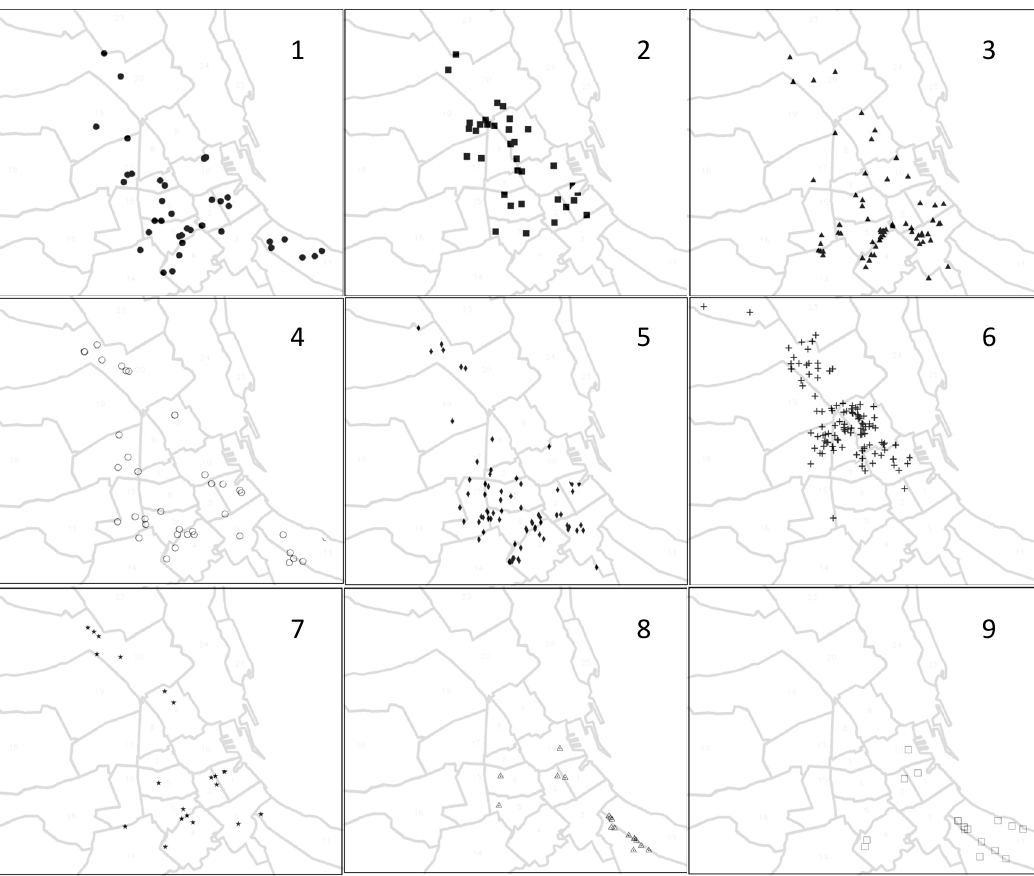
Figure 8. Location of the properties of the nine clusters.